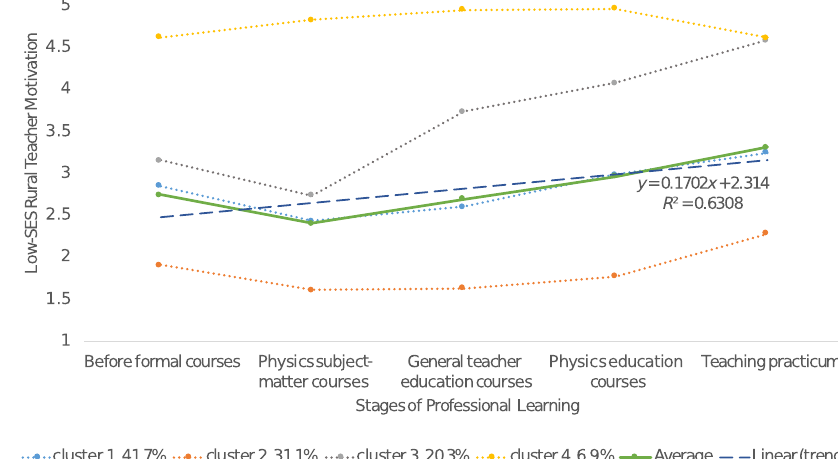
FIG. 1. Preservice physics teacher motivation change across the GPT program. The meanings of the numbers in the vertical axis are as follows: 1, strongly do not want; 2, somewhat do not want; 3, not sure; 4, somewhat want; 5, strongly